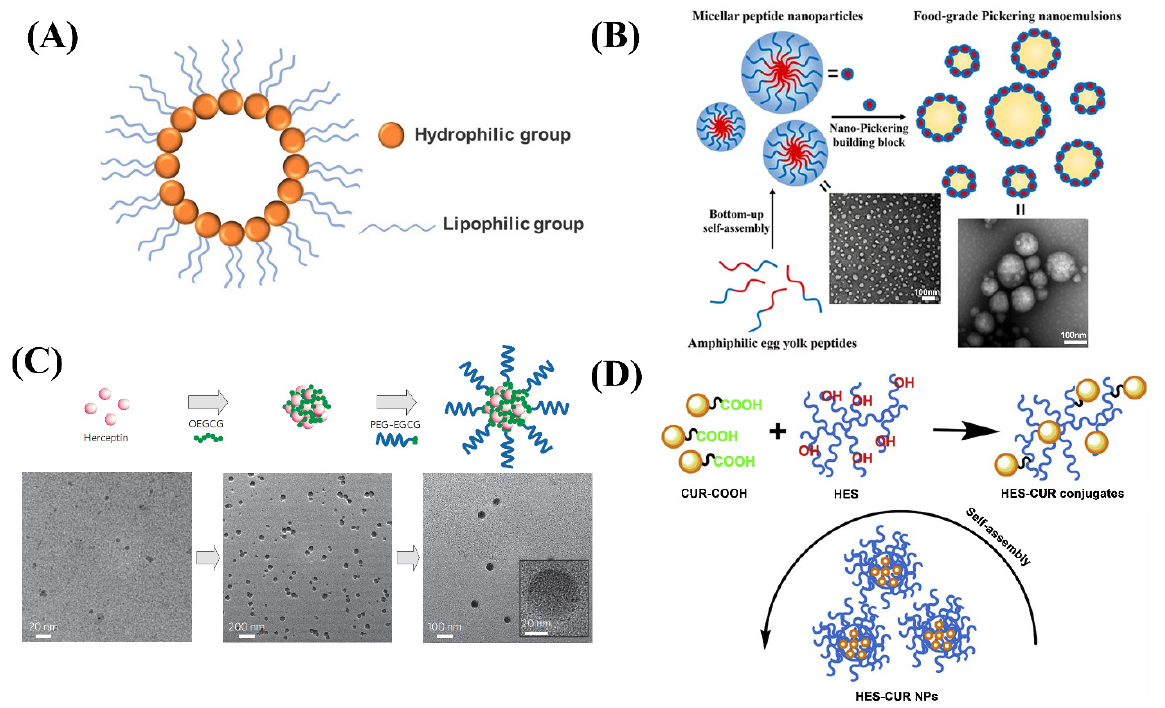
Figure 1. ( A ) The structure of nano micelles. ( B ) Schematic diagram of a spherical micellar nanoparticle self-assembled by yolk peptide. ( C ) Schematic diagram of the self-assembly process of the MNCs and TEM images of MNCs. ( D ) Schematic diagram for the formation process of the HES-CUR NPs.